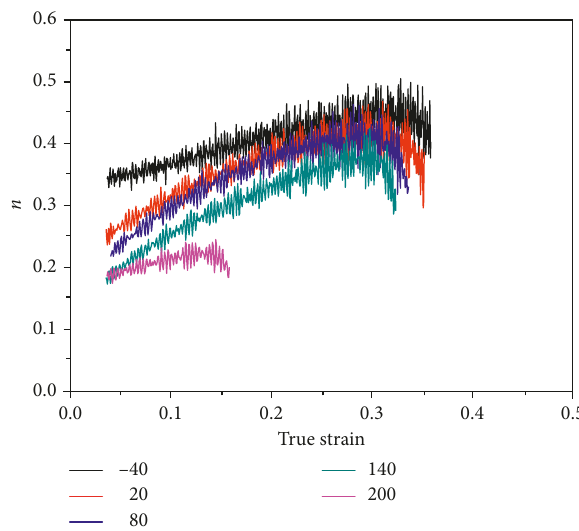
Figure 6: Work-hardening exponent n changes as a function of true strain at various tensile test temperatures.